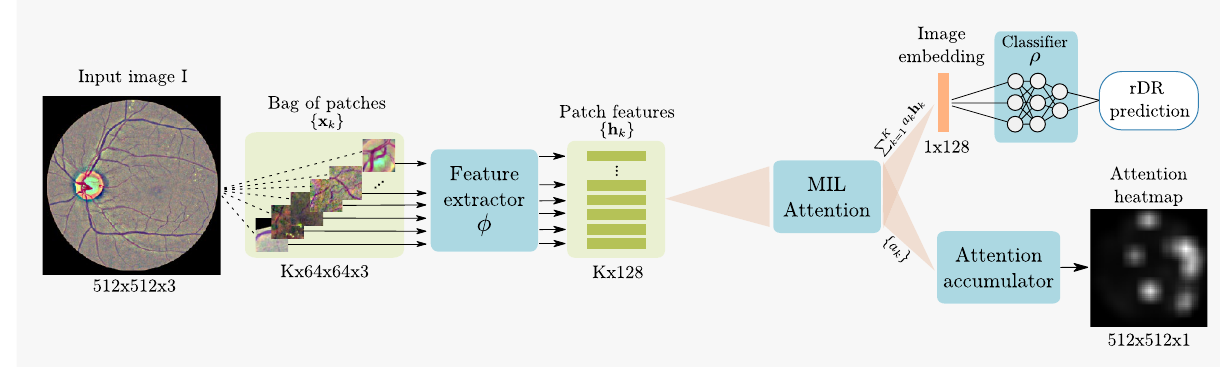
Figure 3. High-level overview of the proposed rDR prediction pipeline. The preprocessed image I is represented by K rectangular patches with fixed overlap that cover most of the retinal disk (patches that have less than 50% retinal content, such as the patches extracted near the boundary of the retinal disk, are discarded). Features are then extracted from each x k patch via a Resnet-18 (function φ ) model Each resulting feature vector h k is assigned a weight α k by an attention mechanism and the weighted average of all the vectors { h k } is used to acquire a single embedding that describes the entire image. Finally, the embedding is fed to a fully connected layer (function ρ ) that outputs the probability of rDR for the given image. At the same time, the attention weights of different patches are mapped to their corresponding image regions and an attention heatmap that highlights the most salient image regions according to the model is